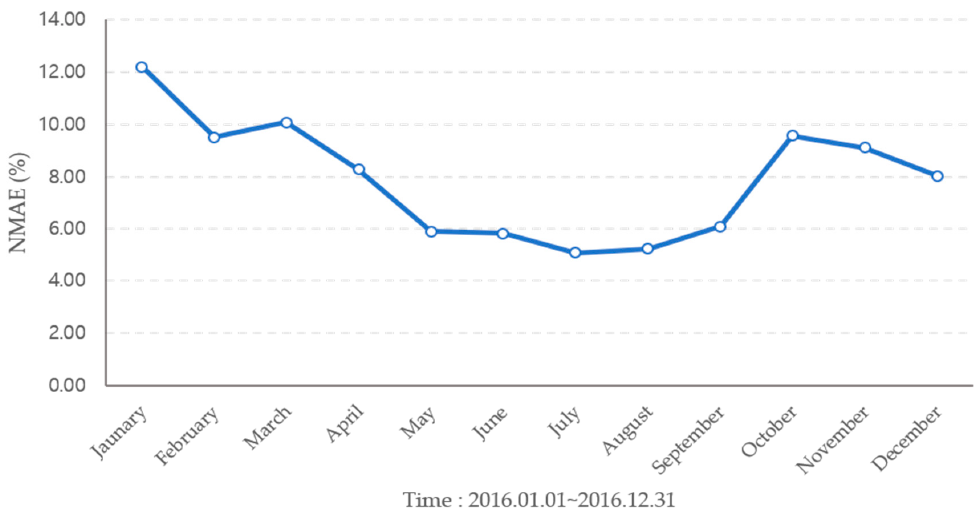
Figure 6. Comparison of the measured and forecast solar power.